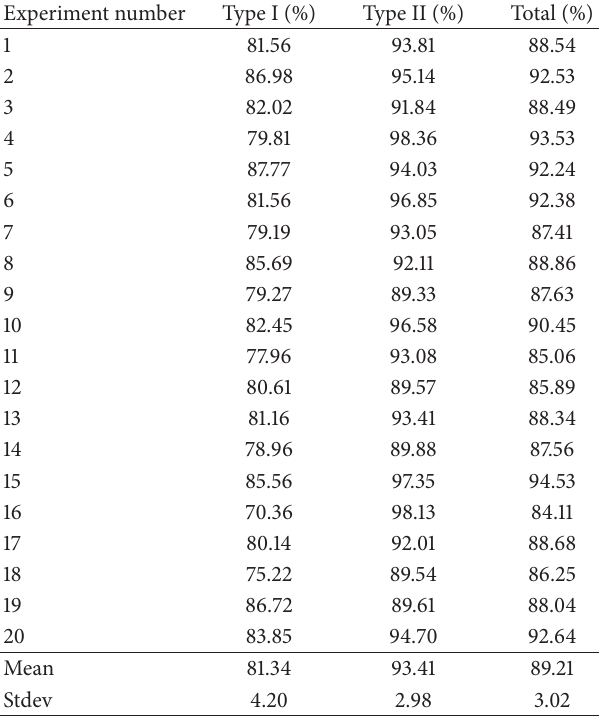
Table 2: Computational results of credit risk evaluation using LS- FSVM.